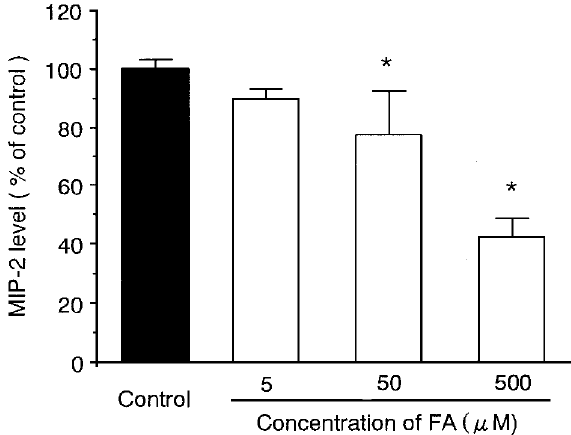
FIG. 1. Inhibitory effect of FA on MIP-2 production in RAW264.7 cells in response to RSV infection. RAW264.7 cells were infected with RSV at an MOI of 3PFU/cell. After absorption for 1h, the cells were cultured in the presence of FA at the indicated concentrations (open bar). The MIP-2 levels in 20-h conditioned media were determined and expressed as MIP-2 level by percent of control cultured in the absence of drugs (closed bar). Asterisks indicate a significant difference from control with a P value of <0.05. Data are shown as the mean (thick bar)± SD (thin bar) of three determinations.